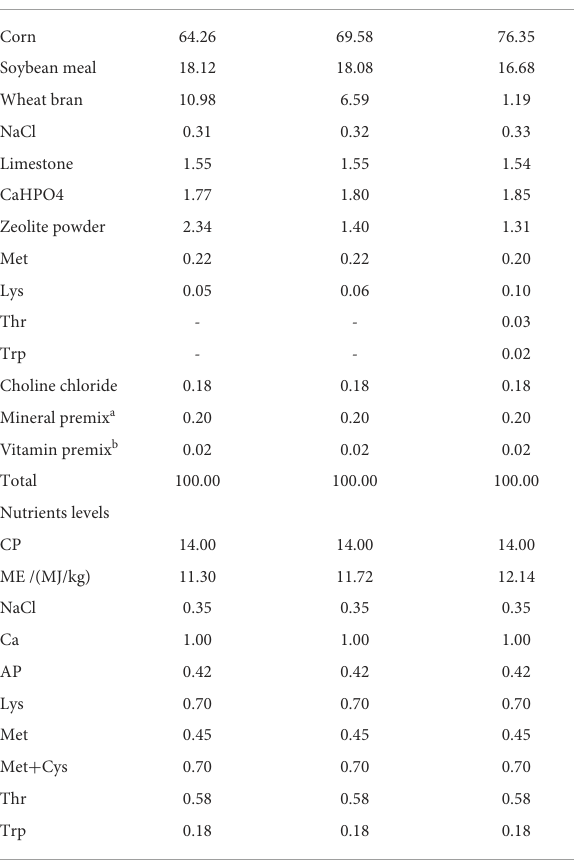
TABLE 1 Ingredients and nutrient composition of experimental diets (DM basis